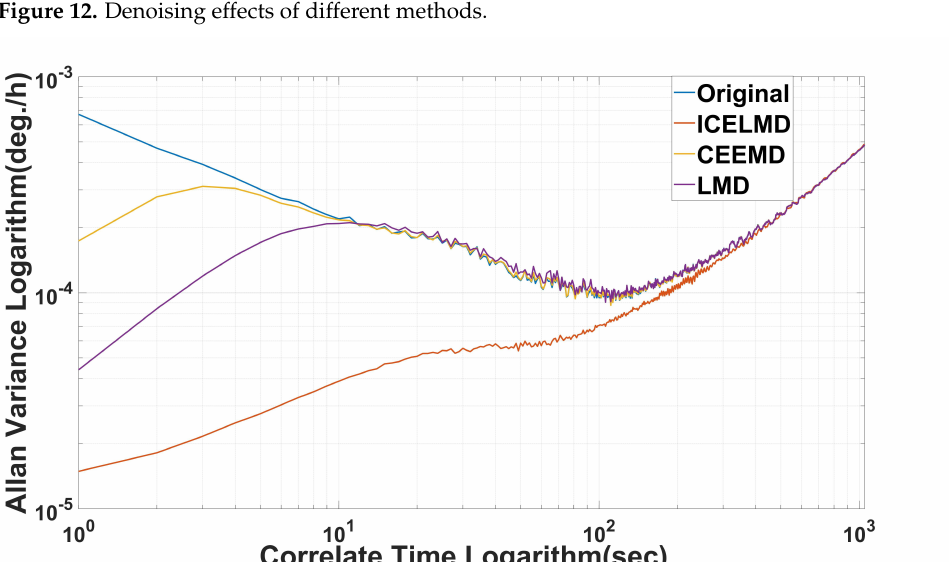
Figure 13. Allan variance of different denoising